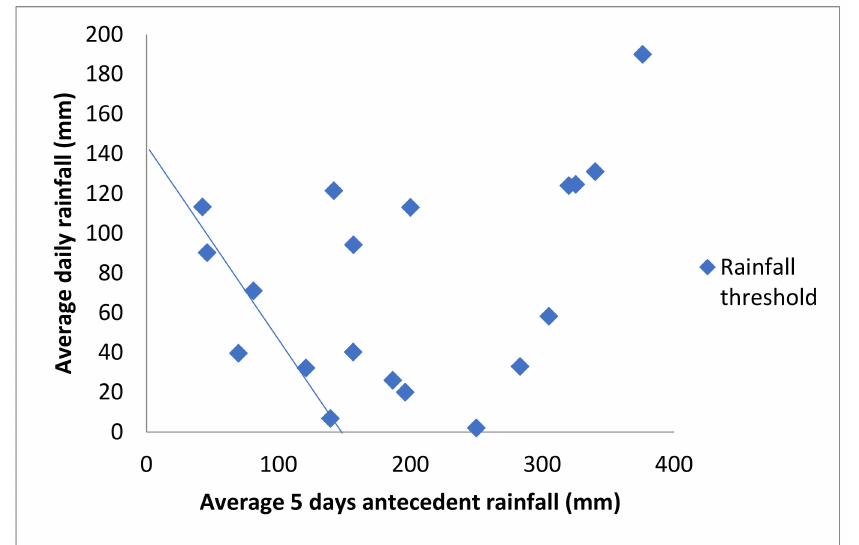
Figure 18. Rainfall threshold with average 5-day antecedent rainfall and average daily